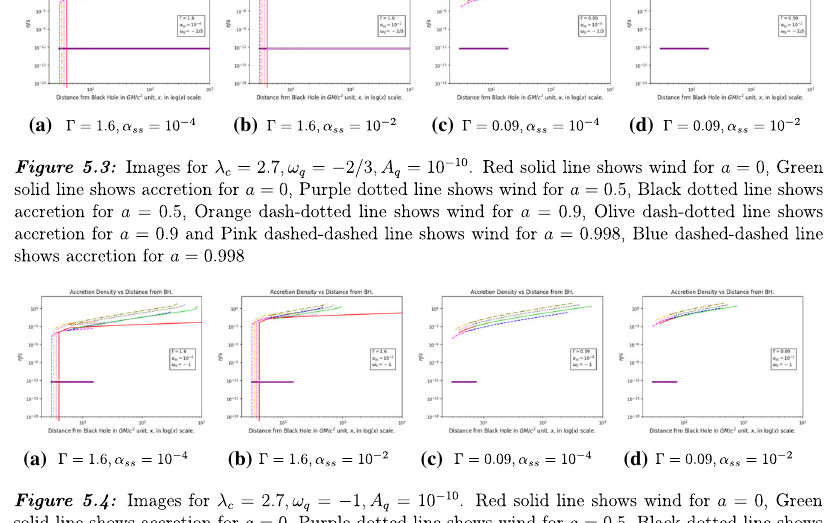
5.3 Images for λ c = 2 . 7 ,ω q = − 2 / 3 , A q = 10 − 10 . Red solid line Fig. 5 Curves for η/ s vs radial distance from BH. 5.1 Images for λ = 2 . 7 ,ω = 1 / 3 , A = 0 . 01. Red solid line shows wind for a = 0, shows wind for a = 0, Green solid line shows accretion for a = 0, Pur- c q q ple dotted line shows wind for a = 0 . 5, Black dotted line shows accre- Green solid line shows accretion for a = 0, Purple dotted line shows tionfor a = 0 . 5,Orangedash-dottedlineshowswindfor a = 0 . 9,Olive windfor a = 0 . 5,Blackdottedlineshowsaccretionfor a = 0 . 5,Orange dash-dotted line shows accretion for a = 0 . 9 and Pink dashed-dashed dash-dotted line shows wind for a = 0 . 9, Olive dash-dotted line shows line shows wind for a = 0 . 998, Blue dashed-dashed line shows accre- accretion for a = 0 . 9 and Pink dashed-dashed line shows wind for a = 0 . 998, Blue dashed-dashed line shows accretion for a = 0 . 998. 5.2 tion for a = 0 . 998. 5.4 Images for λ c = 2 . 7 ,ω q = − 1 , A q = 10 − 10 . Images for λ c = 2 . 7 ,ω q = 0 , A q = 0 . 01. Red solid line shows wind Red solid line shows wind for a = 0, Green solid line shows accretion for a = 0, Purple dotted line shows wind for a = 0 . 5, Black dotted line for a = 0,Greensolidlineshowsaccretionfor a = 0,Purpledottedline shows accretion for a = 0 . 5, Orange dash-dotted line shows wind for shows wind for a = 0 . 5, Black dotted line shows accretion for a = 0 . 5, a = 0 . 9, Olive dash-dotted line shows accretion for a = 0 . 9 and Pink Orange dash-dotted line shows wind for a = 0 . 9, Olive dash-dotted line dashed-dashedlineshows windfor a = 0 . 998, Bluedashed-dashedline shows accretion for a = 0 . 9 and Pink dashed-dashed line shows wind shows accretion for a = 0 . for a = 0 . 998, Blue dashed-dashed line shows accretion for a = 0 . 998.